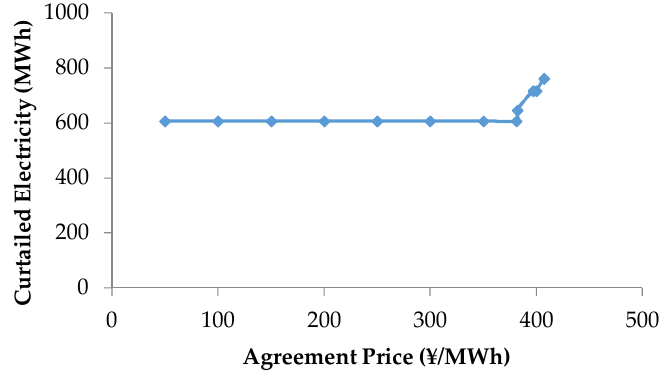
Figure 5. Wind curtailment under different agreement prices.